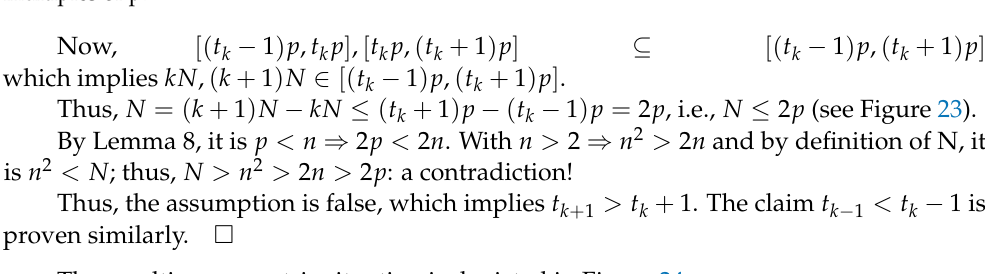
Figure 23. Situation in case kN and ( k + 1 ) N lying within two consecutive intervals of consecutive multiples of p.